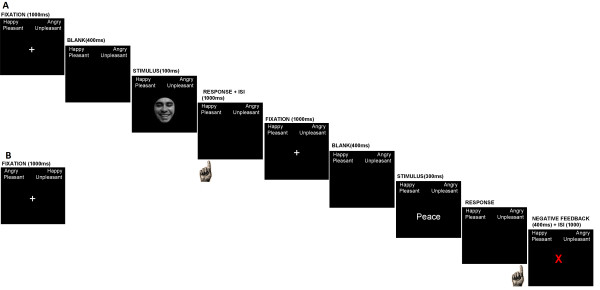
Sequence representation for compatible test block. A. The schema shows a face and a word sequence presentation and the participant's response. Face and word trials are alternately presented for a short time, strictly. Positive and negative faces, along with words of positive and negative valence, are present in the stimuli set and are presented in a randomized sequence. The participant is required to classify each stimulus to the left or to the right according to labels displayed on top of the screen. When a classification response error is made, negative feedback is given (i.e., in the word sequence illustrated in the figure). B. During the incompatible block test the valence classification of a face (e.g., happy-left vs. angry-right) must be classified in the opposite valence direction of the word (unpleasant-left vs. pleasant-right). When items from compatible categories (e.g. happy + pleasant) share a response key, performance is faster and more accurate than when items from incongruent categories (e.g. angry + pleasant) share a key